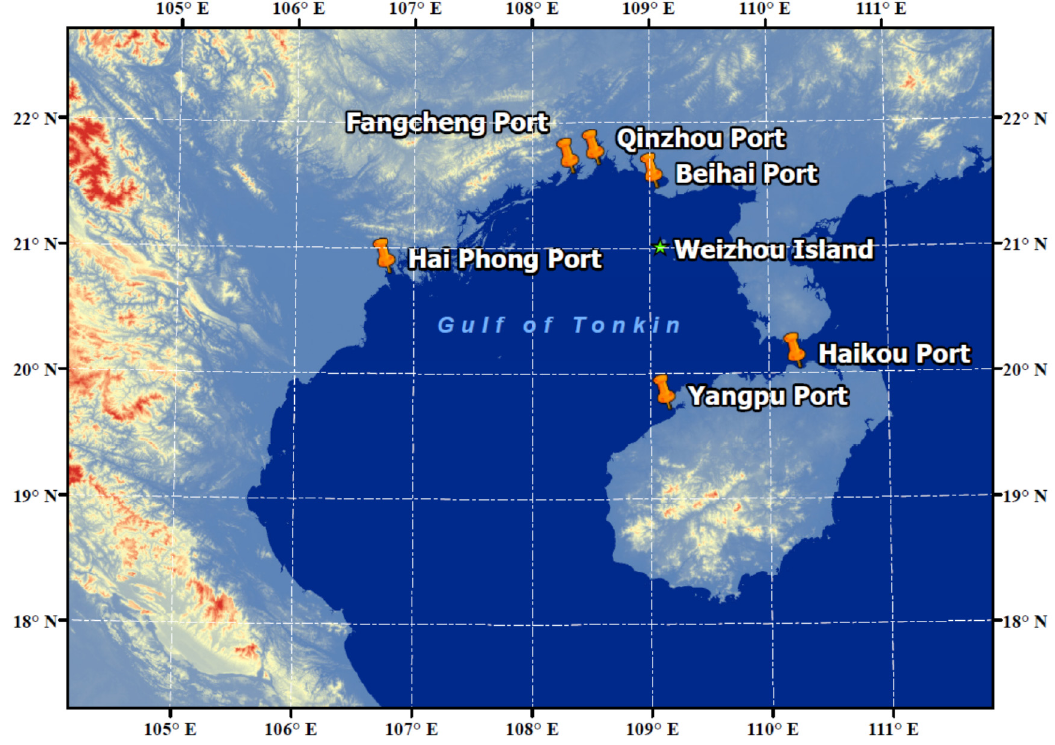
Figure 1. Location of the Weizhou Island in Gulf of Tonkin (GT).